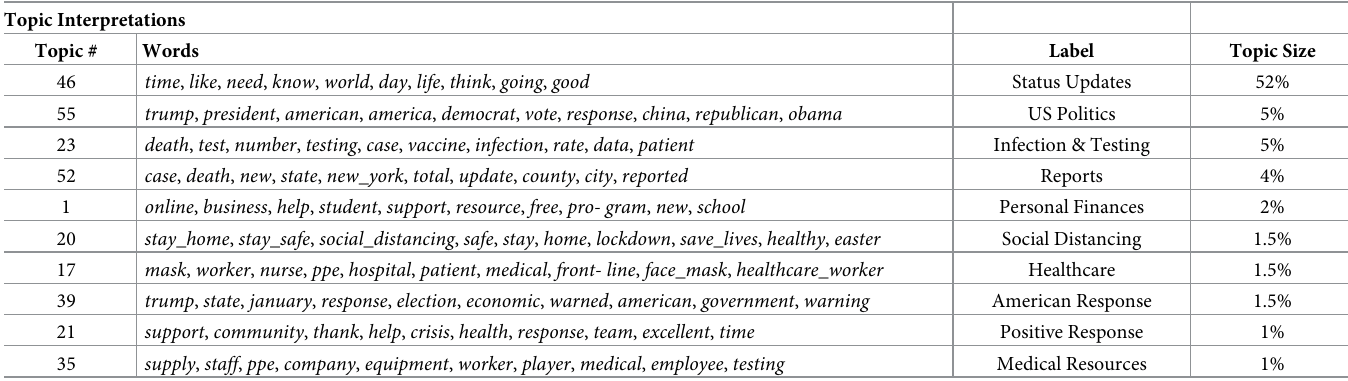
Table 4. Topic word representations for April 13th and custom labels.